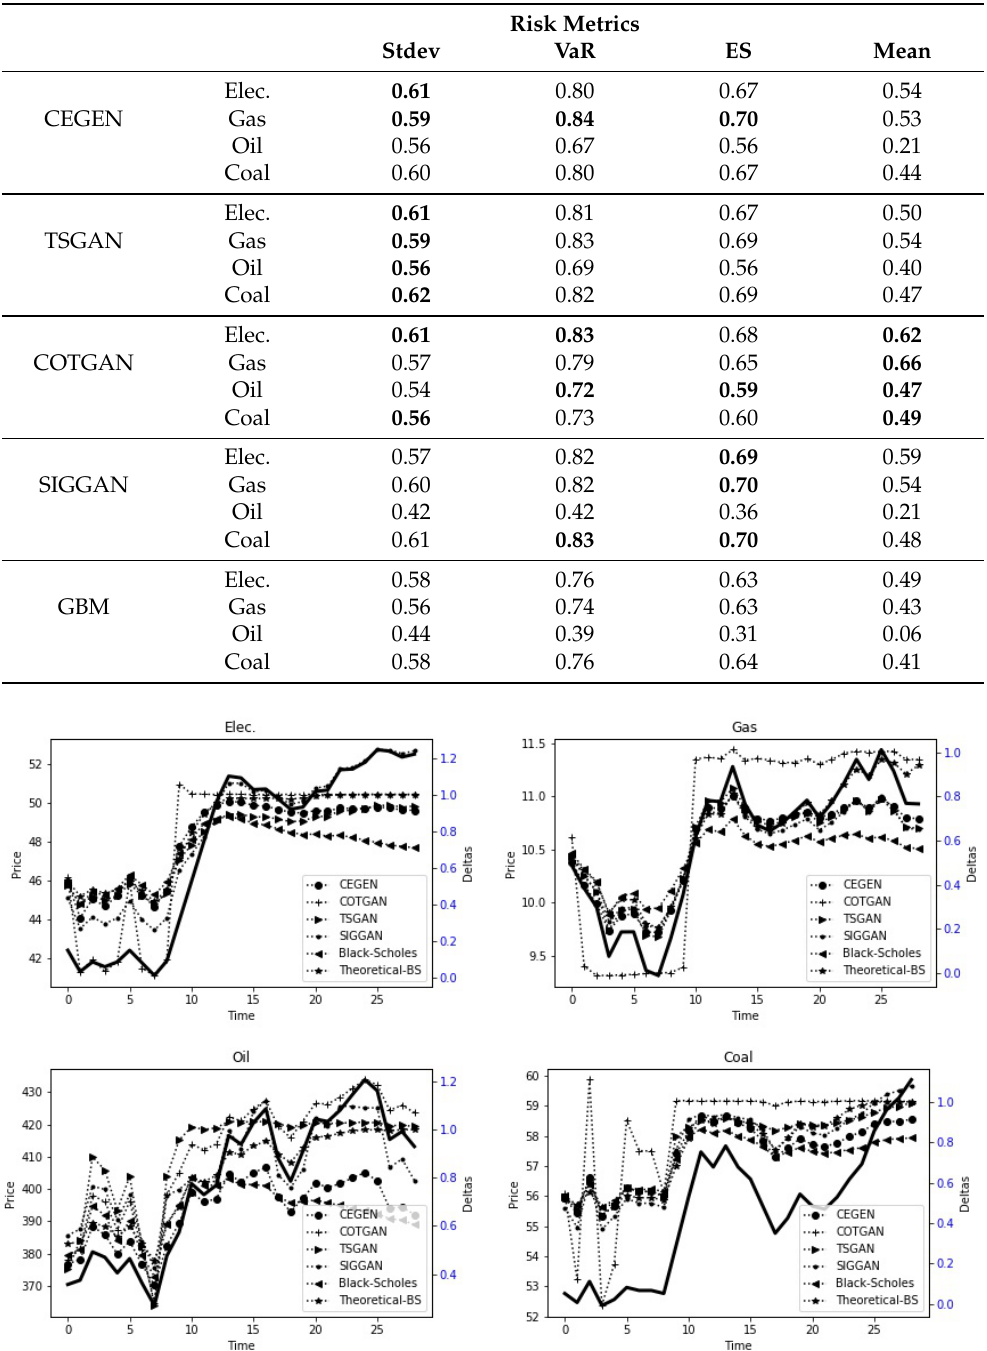
Table 3. Hedging scores of at-the-money call options. For all scores, the closer to 1, the better. Bold values indicate best scores.